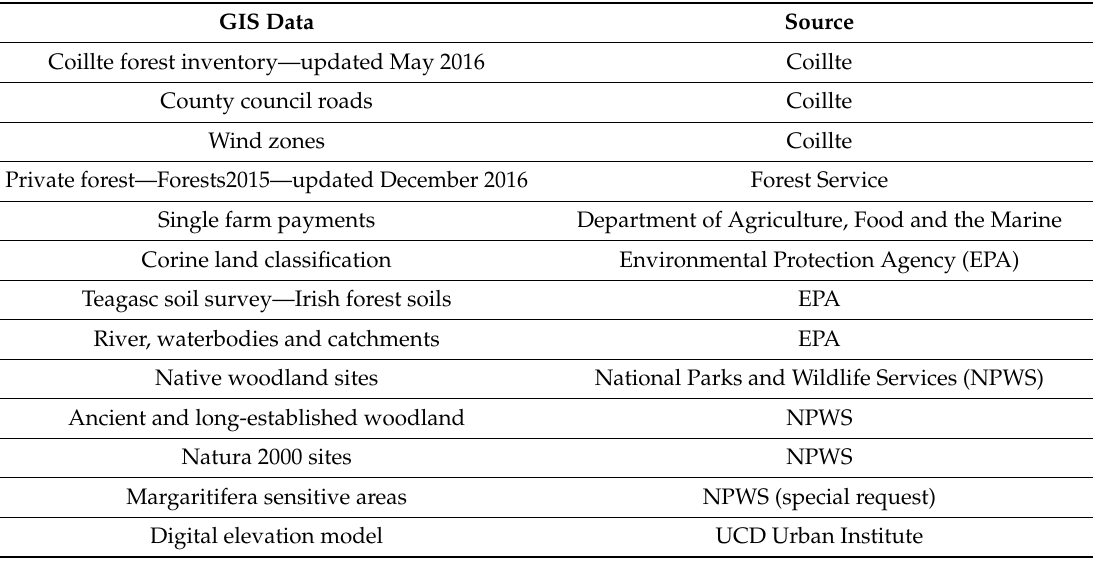
Table 2. GIS data sources used to create the land-use layer that was imported into